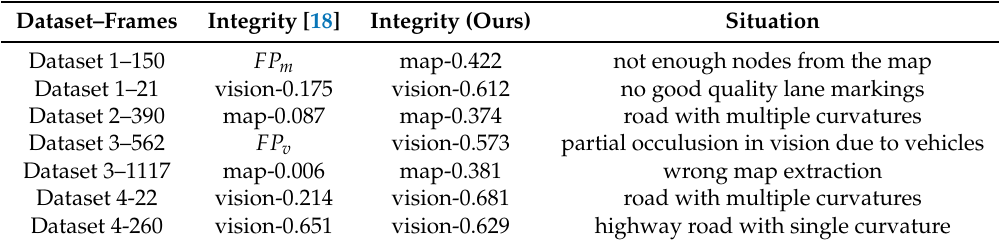
Table 1. Results obtained using the proposed method and the method presented in